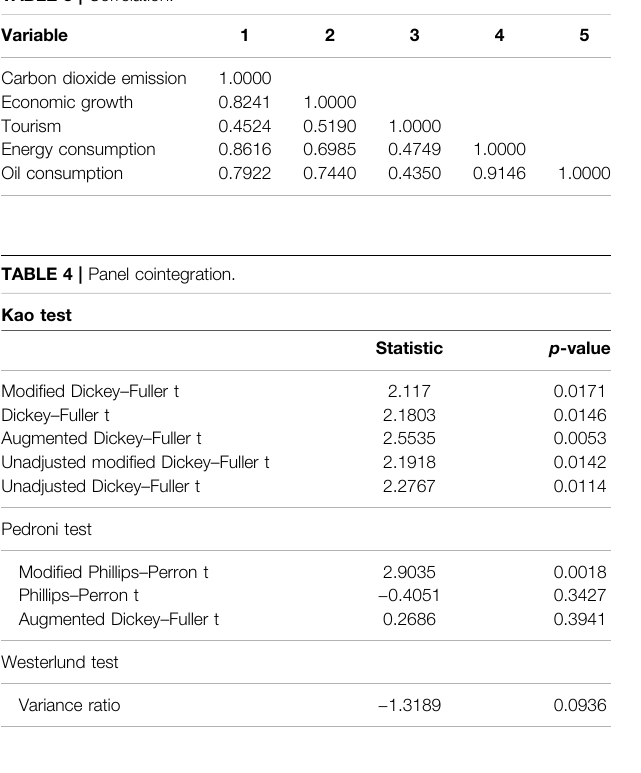
TABLE 5 | PMG long-run results.